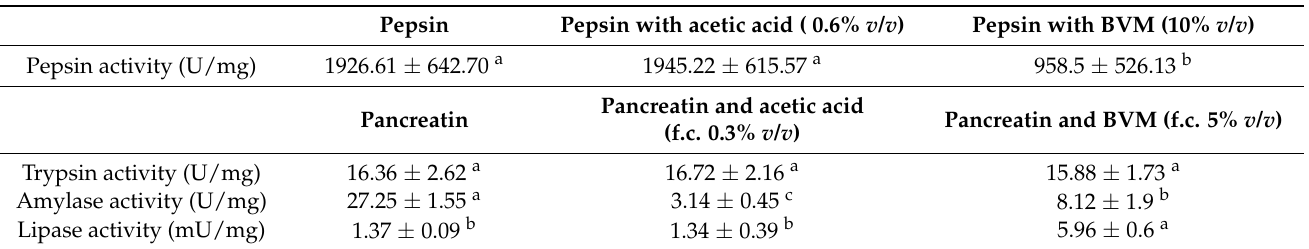
Table 1. Digestive enzymes activity in the absence/presence of acetic acid and balsamic vinegar of Modena (BVM). Data are means ± SD of six replicates. Statistical analysis was by the one-way ANOVA (pepsin: p < 0.05; amylase and lipase: p < 0.001) with Tukey’s post hoc test. Different letters in the same row indicate significant difference (at least p <